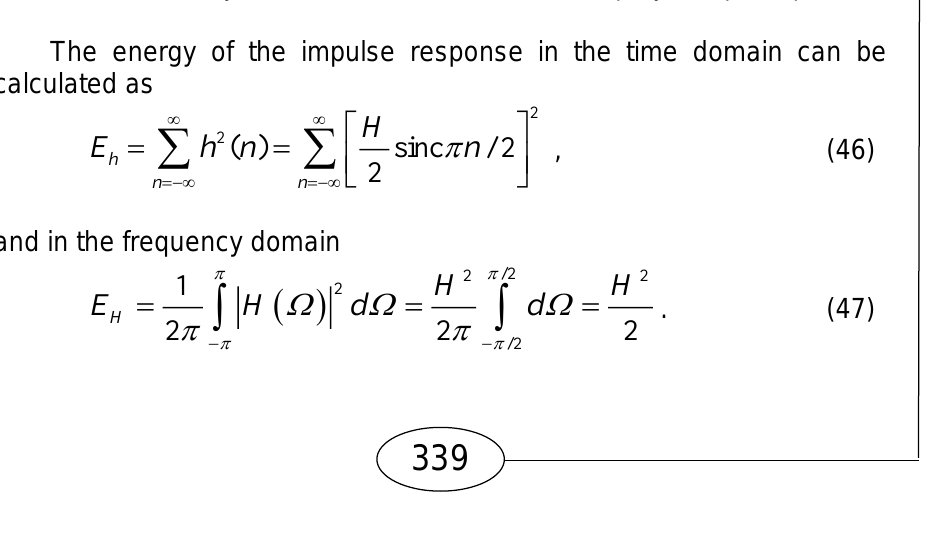
Figure 16 − Impulse response and the output of the ideal LP filter Рис. 16 – Импульсная характеристика и выходной сигнал идеального LP-